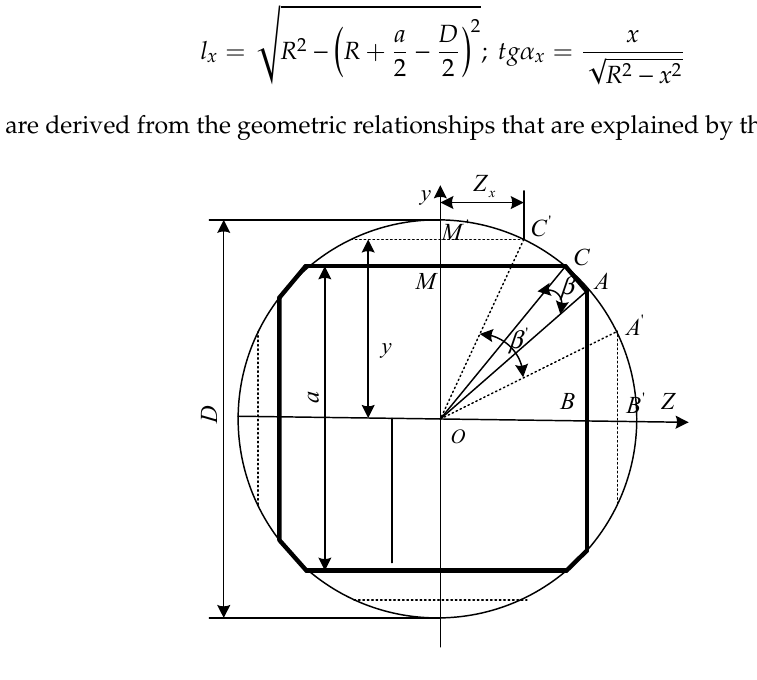
Figure 5. Explanations for the derivation of equations for l x and tg α x